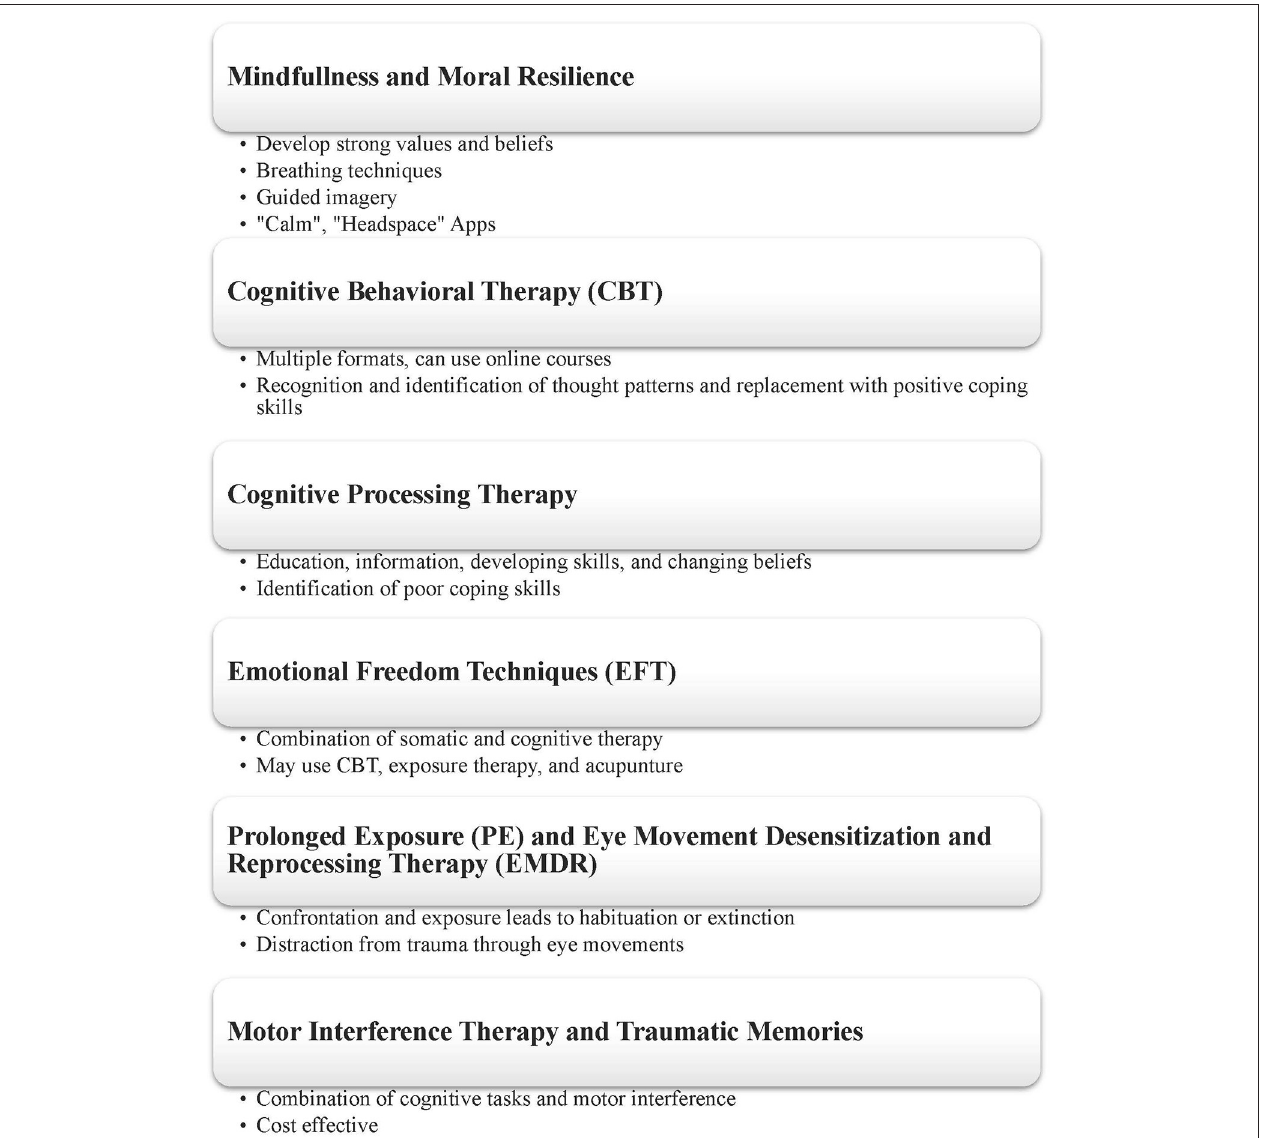
FIGURE 2 | Overview of coping strategies used to prevent the development of mental health disorders during COVID-19.